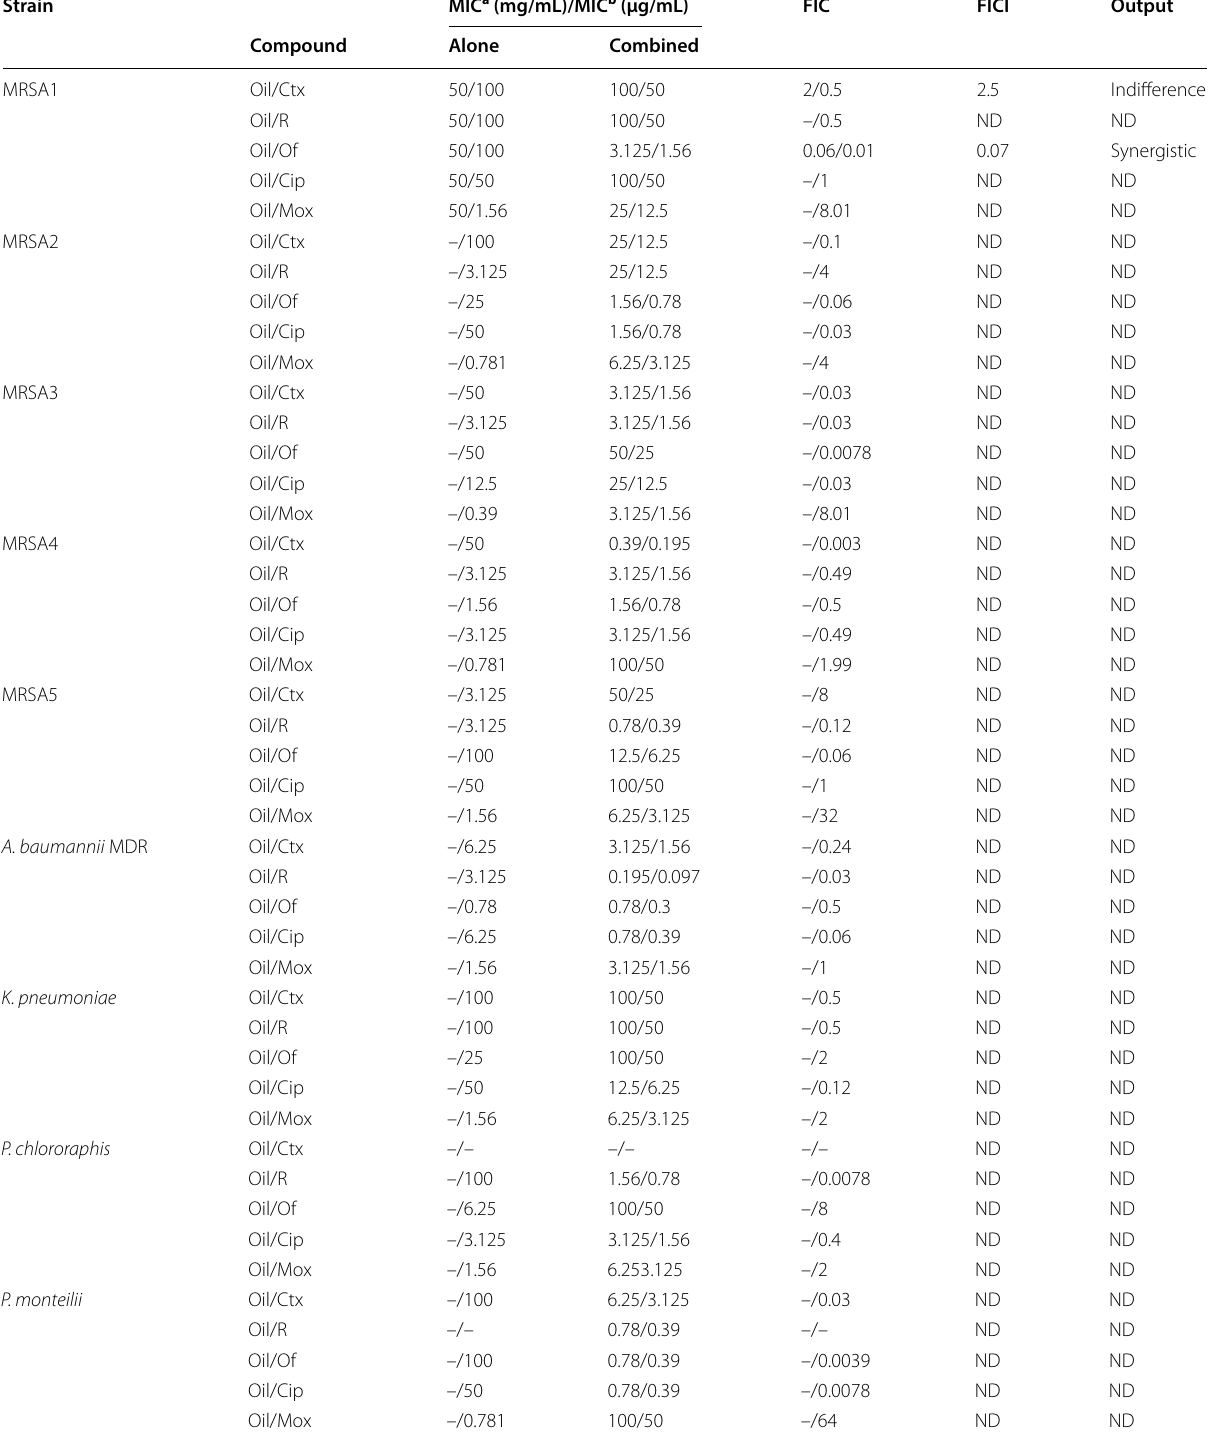
Table 8 Minimum inhibitory concentration (MIC) and fractional inhibitory concentration (FIC) of seed oil, each